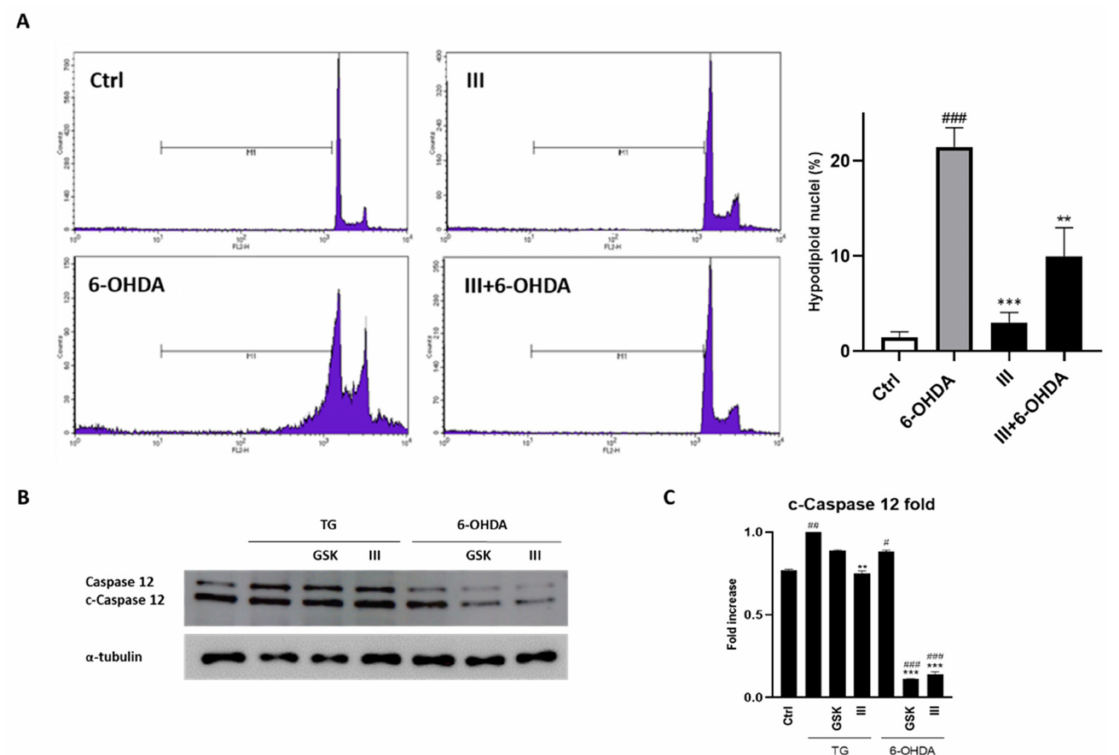
Figure 5. Effect of fraction III (6 µ g/mL) on apoptosis, evaluated by propidium iodide assay via. cytofluorimetric technique ( A ) and Western blotting for evaluation of caspase-12 cleavage ( B ) on SH-SY5Y cells treated with 6-OHDA (50 µ M). Related densitometric analysis is reported in ( C ). Data are expressed as percentage of hypodiploid nuclei. Results are showed as mean ± standard deviation (SD) from three independent experiments. #, ##, ### denote respectively p < 0.05, p < 0.01 and p < 0.001 vs. Ctrl; **, *** denote p < 0.01 and p < 0.001 vs.